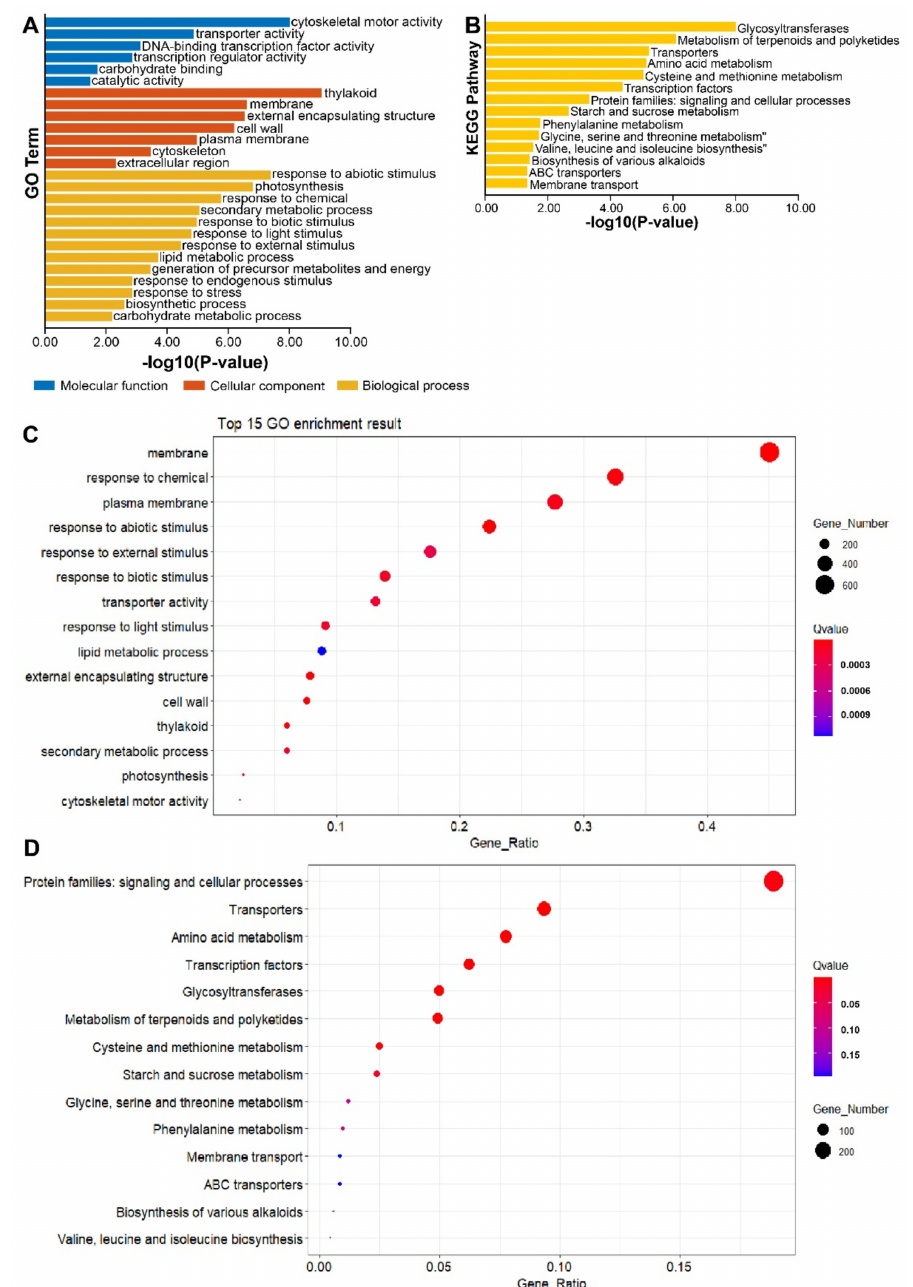
Figure 5. GO and KEGG pathway enrichment plot. The GO ( A ) and KEGG ( B ) enrichment plots were constructed by TBtools. Both GO and KEGG enrichment p -value of pathways were verified by the BH method. In addition, the bubble plots used the bubble shiny plugin ( C , D ). The circle color represented the enrichment degree, and the size of the circle represented the differential genes participating in a certain